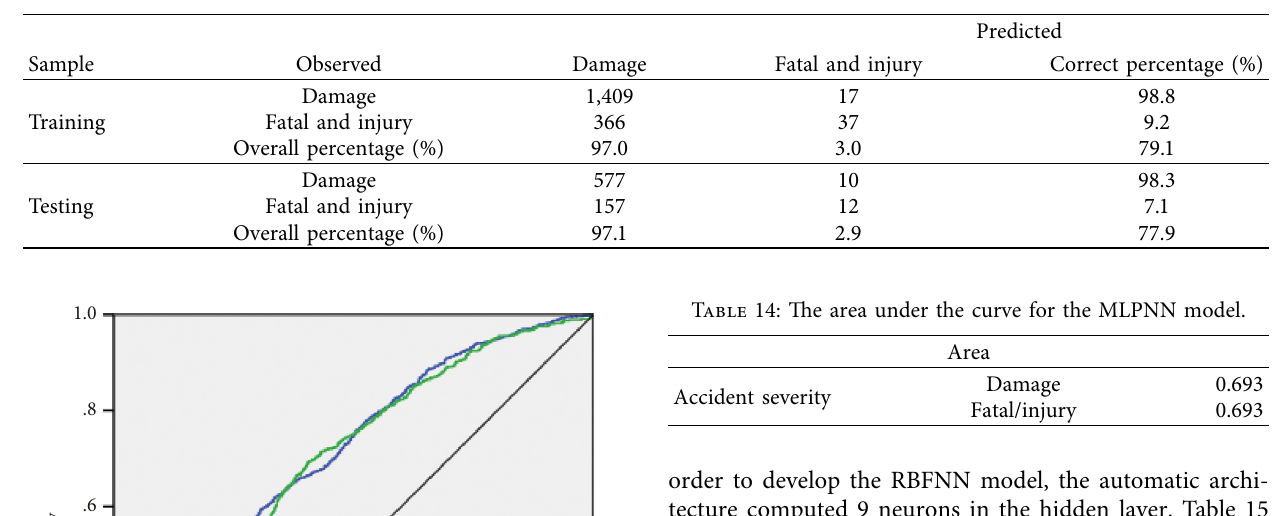
Table 13: Classification in the MLPNN